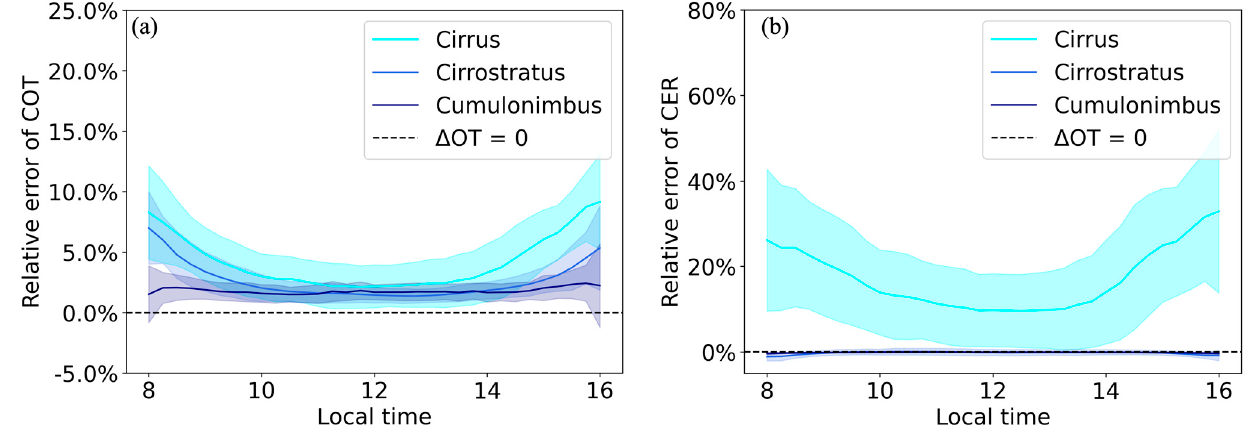
Figure 10. The contribution of each type of high cloud to the relative error of ( a ) COT and ( b ) CER retrievals as a function of LT with Case C sub-sampling.